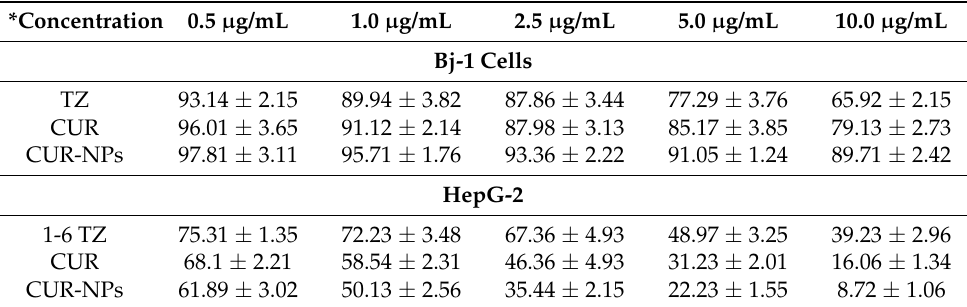
Table 1. Viability and cytotoxic activity of TZ, CUR and